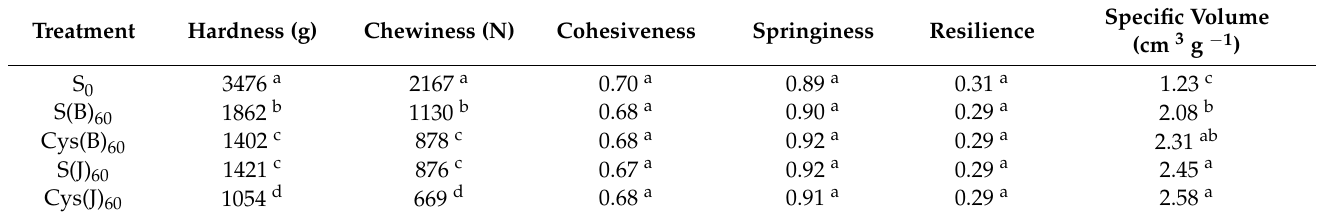
Table 4. Effects of cysteine and inorganic sulfur application at different stages on texture parameters of